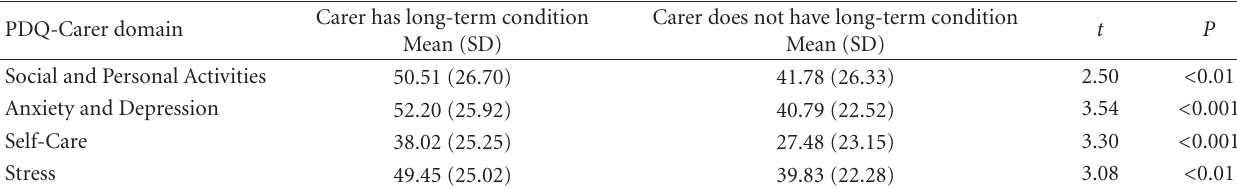
Table 3: Comparisons of carer quality of life by health status.